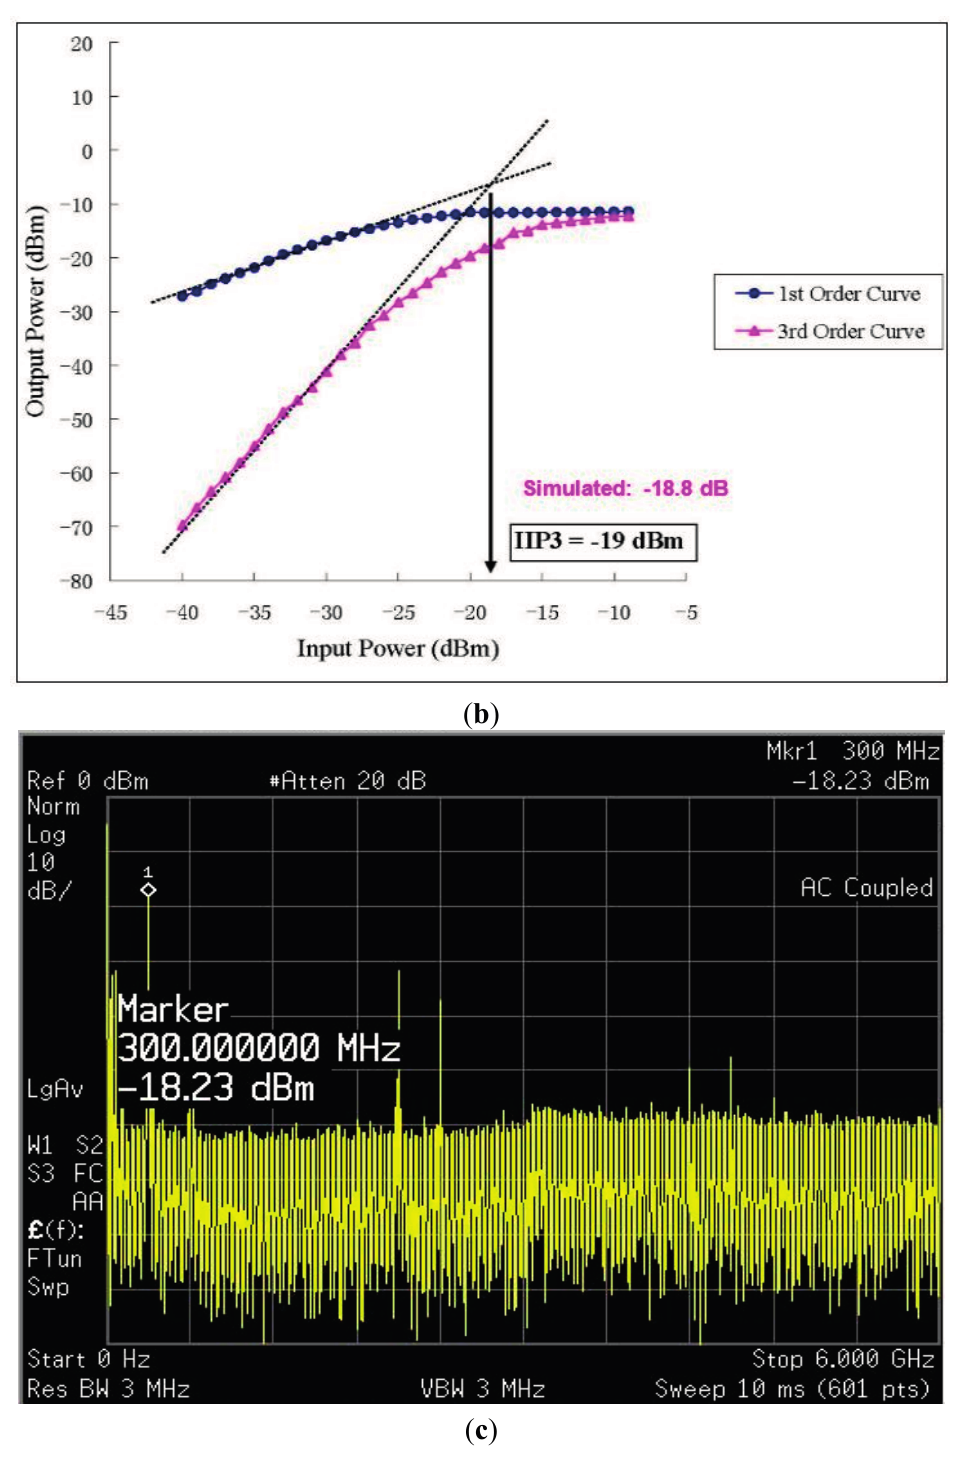
Figure 8. ( a ) IIP 3 of narrowband receiver front-end; ( b ) Measured IIP 3 of narrowband receiver front-end; ( c ) Spectrum of two-tone